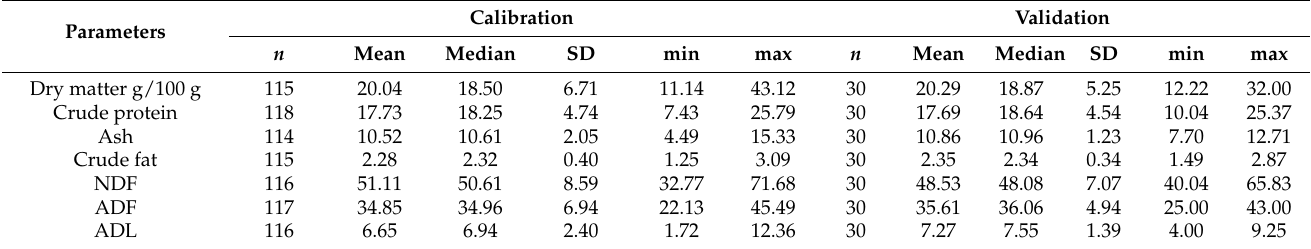
Table 1. Descriptive statistics of wet chemistry reference analysis of the samples.